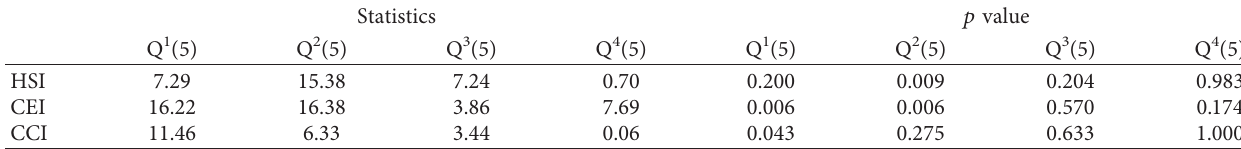
Table 5: Autocorrelation tests of the first four moments of standardized residuals. Statistics